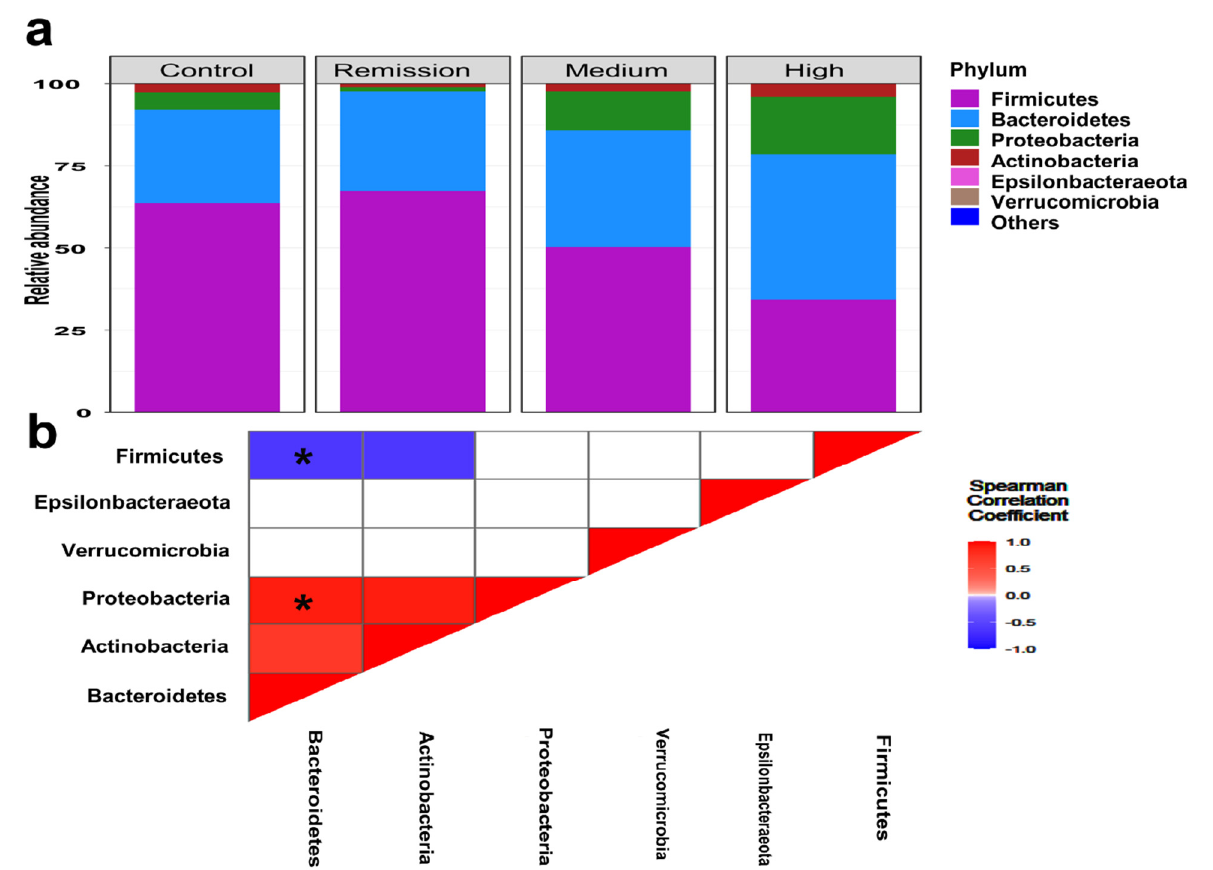
Figure 1. Phylum level analysis of gut microbiota. ( a ) Bar charts illustrate the relative abundance of the main phyla in the gut microbiome of studied groups. The X-axis defines the studied groups. The mean relative proportions of the dominant phyla in DAS28 groups were plotted on the Y axis. ( b ) Corrplot defines the association between the main phyla in RA microbiomes. Spearman correlation coefficient was used to define the correlation between the dominant phyla ( r ≥ ±0.6, * p ≤ 0. 05).